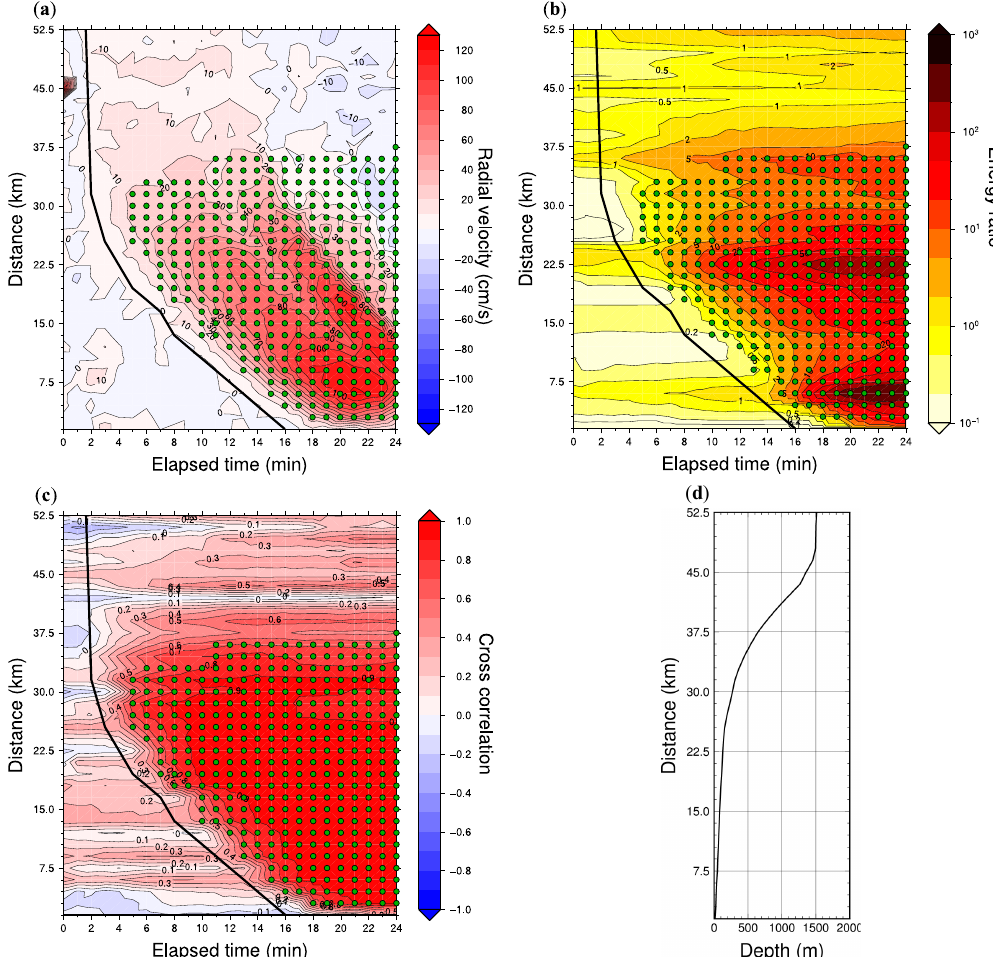
Figure 7. Time-distance diagrams of ( a ) v (cid:48) vt ( 04, m , t ) , ( b ) E ratio ( 04, m , t ) , ( c ) cor vt ( 04, m , t ) , and detection results along beam 04 for the 02010600 scenario. Green circles represent the time, t d ( 04, m ) , when the tsunami was detected, ( TD ( b , m ) = 1), and the black line represents the track of the first leading wavefront of the tsunami. ( d ) Water depth along the beam.